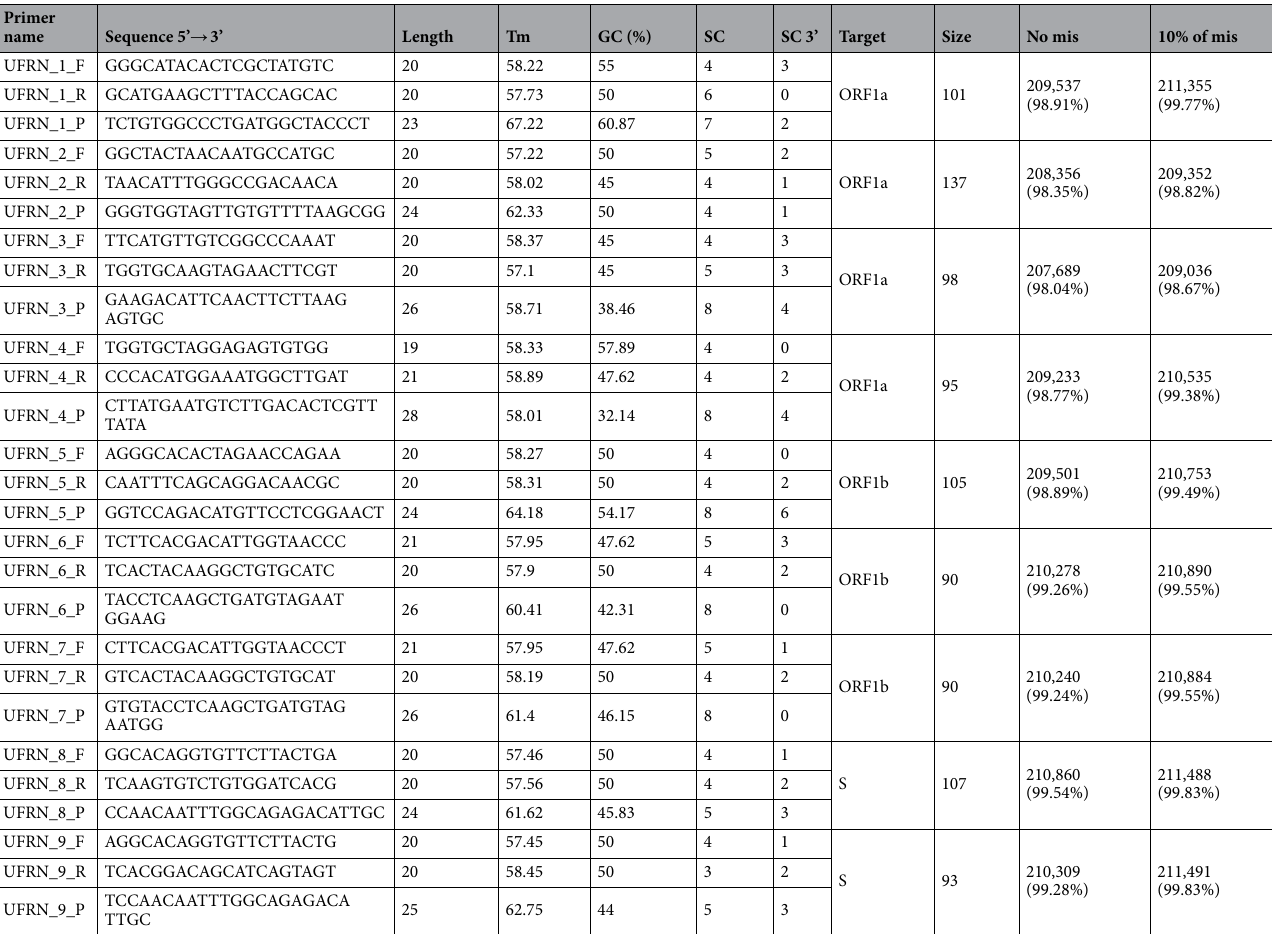
Table 1. Primers designed in this study. The percentage of the total number of sequences that annel without mismatches or allowing 10% mismatches are shown in parentheses. F forward primer; R reverse primer; P probe; Tm melting temperature; GC% = G + C percentage; SC self complementarity; SC 3’ self 3’-complementarity; No mis number of sequences that anneal to the primer without mismatches; 10% mis number of sequences that anneal to the primer allowing 10%